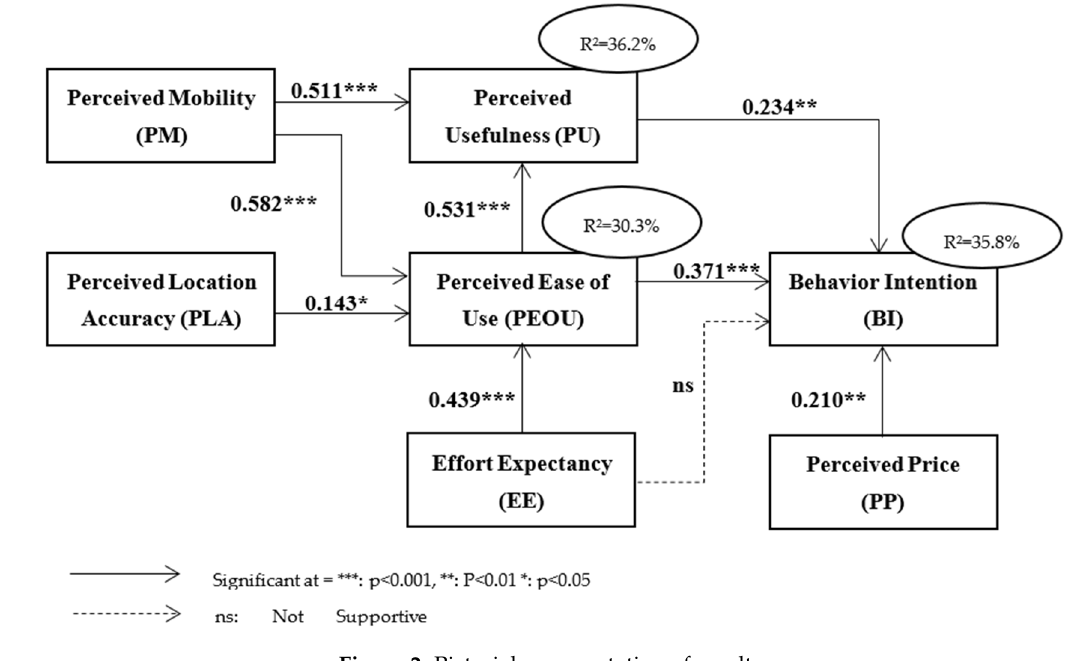
Figure 2. Pictorial representation of results.